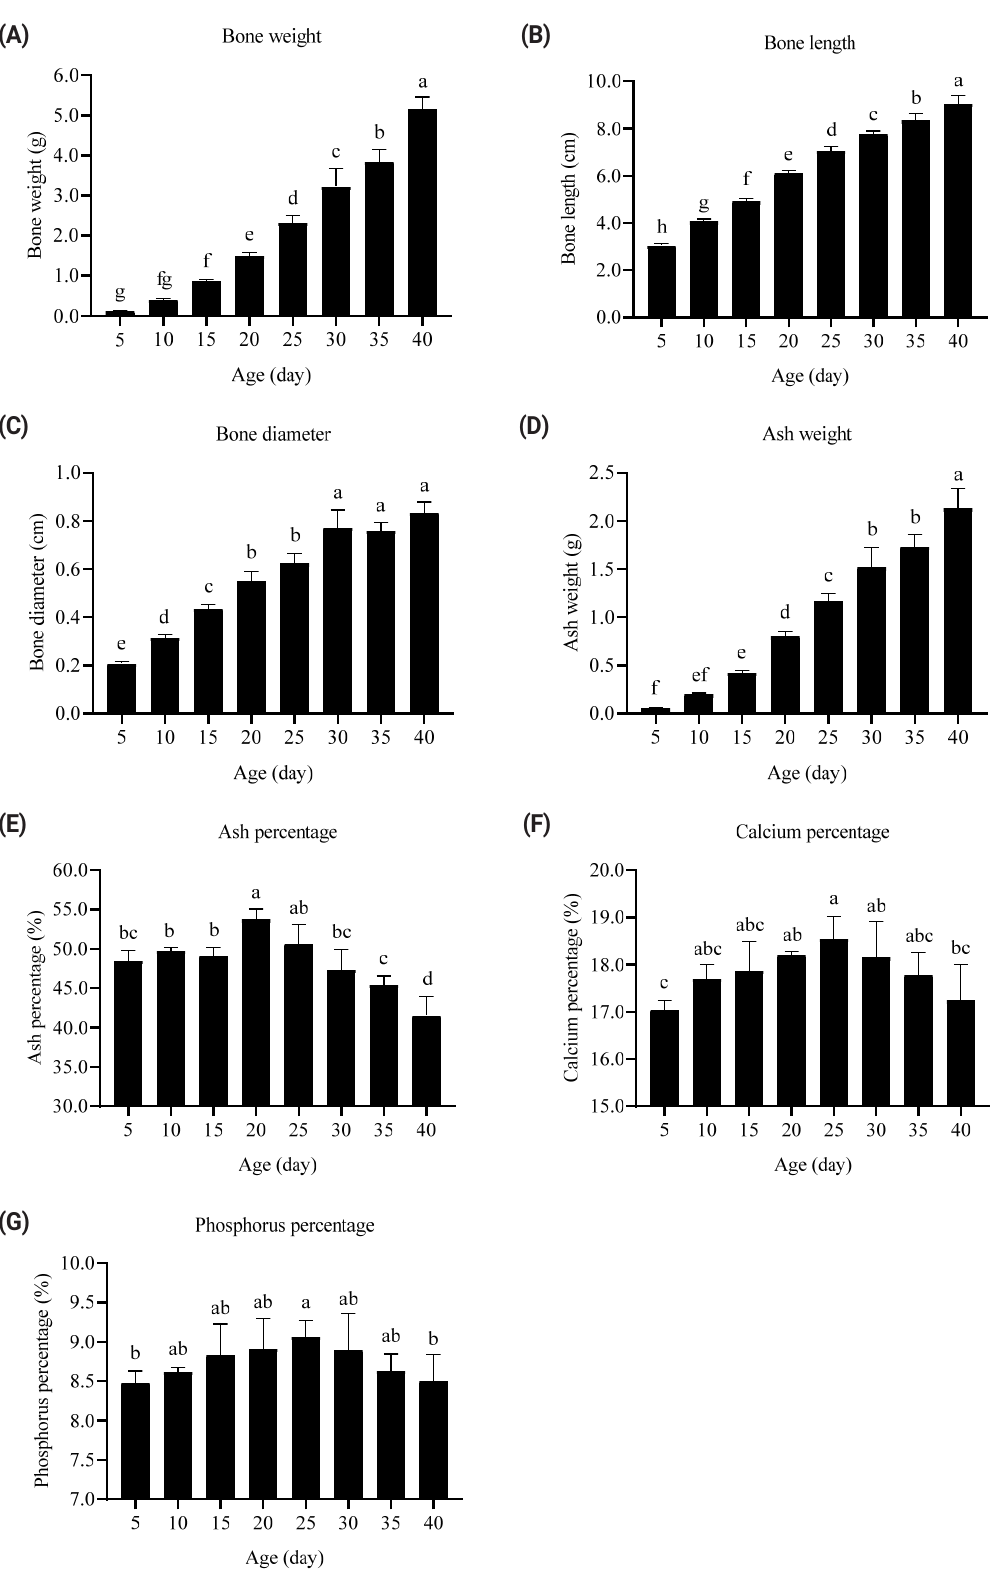
Figure 2. Effects of age on the bone weight (A), length (B), diameter (C), ash weight (D), ash percentage (E, quadratic p<0.001), calcium percentage (F, quadratic p<0.001), and phosphorus percentage (G, quadratic p<0.001) in the tibia of broilers from 5 to 40 days. The values are the means of eight broilers (n = 8) and presented as mean±standard deviation. a-h Values with different superscripts are significantly different (p<0.05).